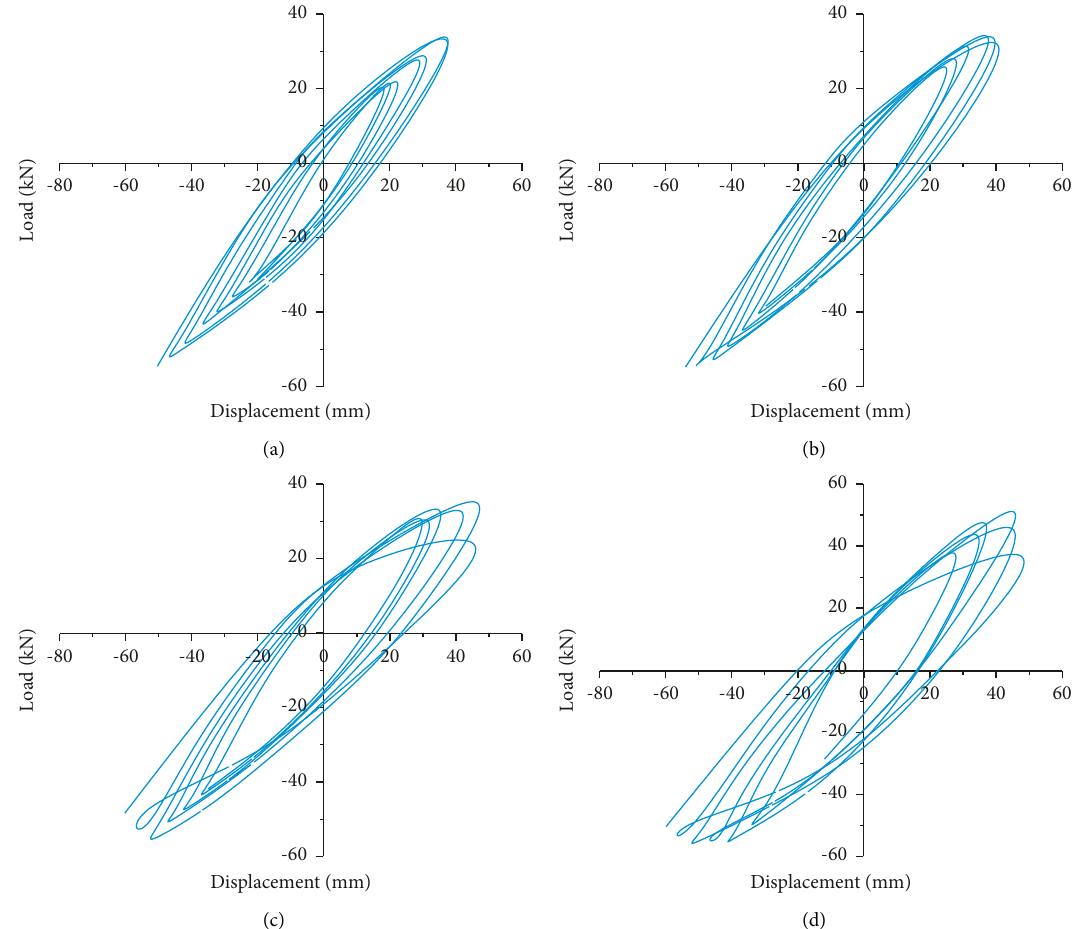
Figure 17: Hysteretic curves of joints with different concrete strength grades. (a) C20 concrete, (b) C25 concrete, (c) C30 concrete, and (d) C40 concrete.